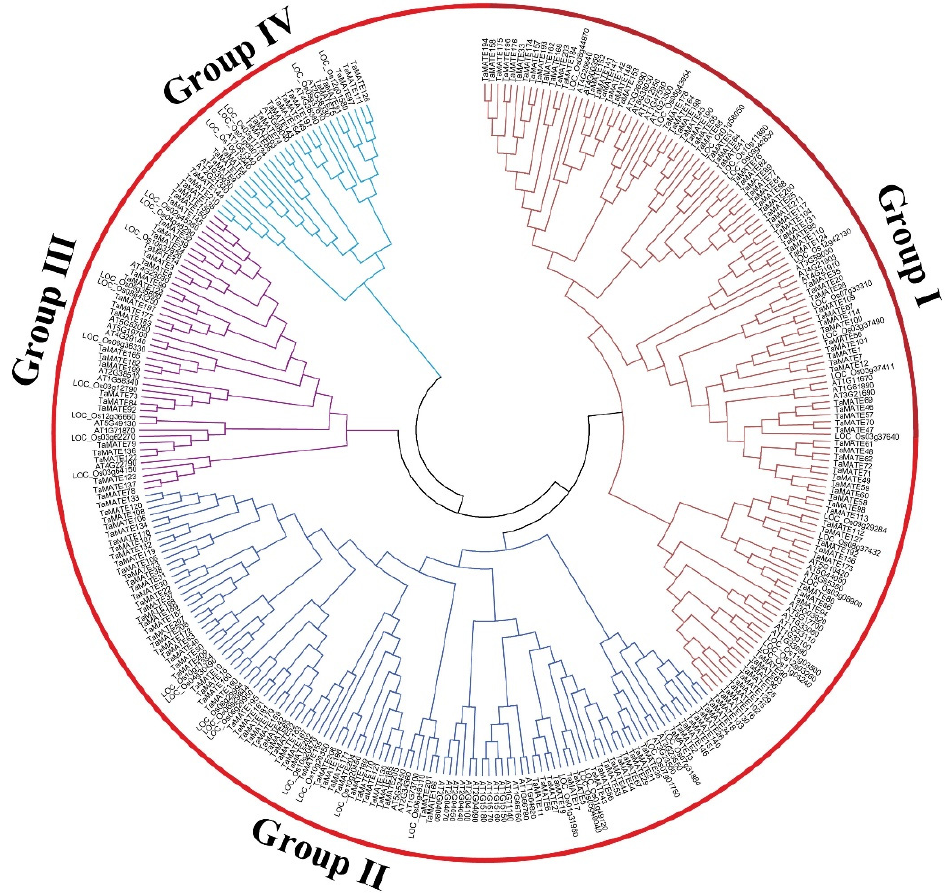
Figure 1. The Bayesian phylogenetic tree of MATE (multidrug and toxin efflux) gene family from Triticum aestivum , Arabidopsis thaliana and Oryza sativa . Group I, II, III and IV represent four different subfamilies.